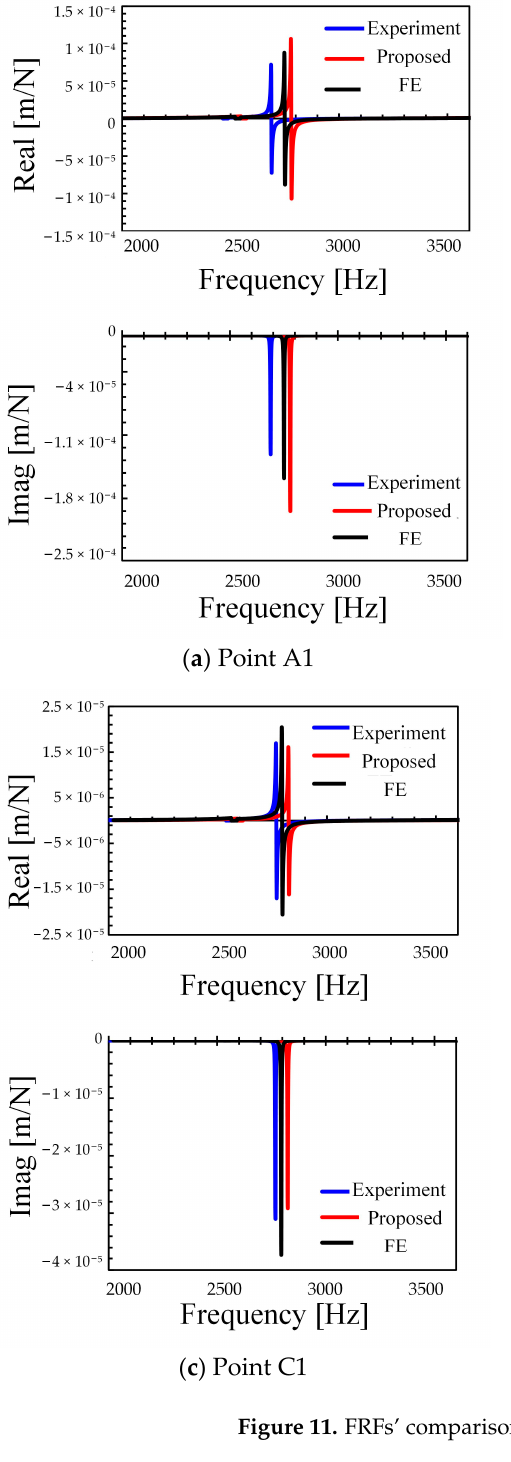
Table 1. Natural frequency comparison between experiment and prediction. Point Experiment [Hz] Proposed Method [Hz]